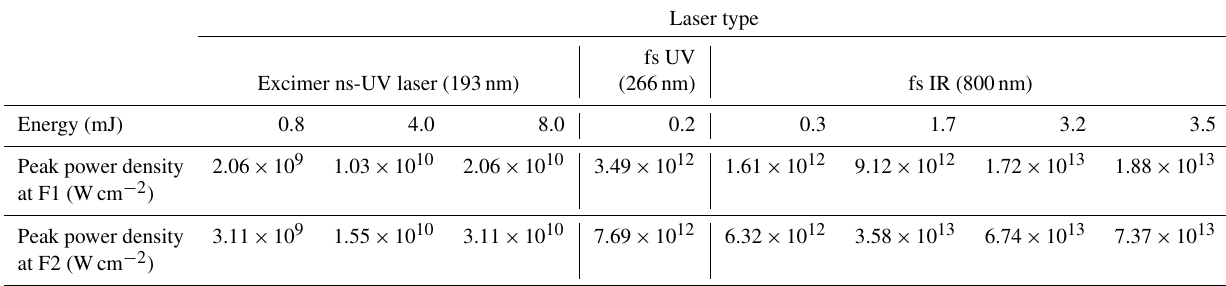
Table 2. Excimer ns-laser and fs-laser pulse energies and corresponding power densities at positions F1 and F2. The corresponding beam diameters are given in Table